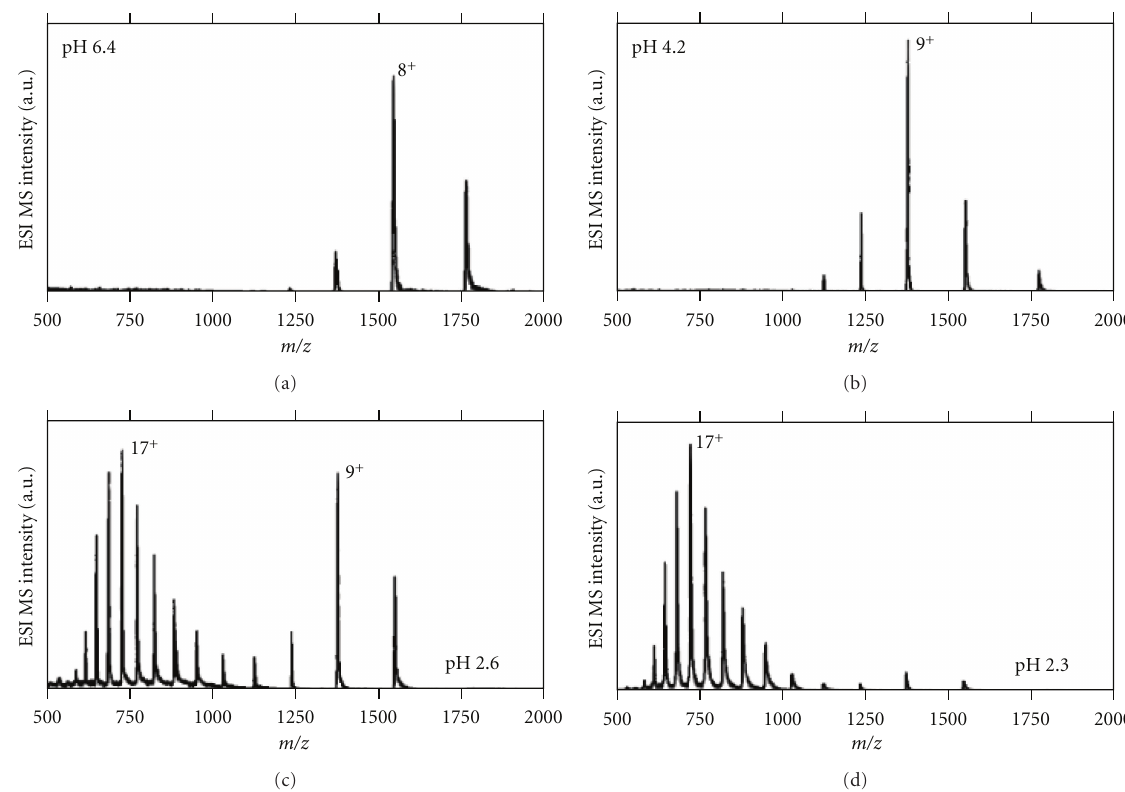
Figure 11: ESI-mass spectra of cyt c in water containing 3% methanol and 0.5mM ammonium acetate at (a) pH 6.4, (b) pH 4.2, (c) pH 2.6, and (d) pH 2.3. The pH was adjusted by the addition of hydrochloric acid. (Reprinted with permission from Biochemistry [80], Copyright 1997, American Chemical